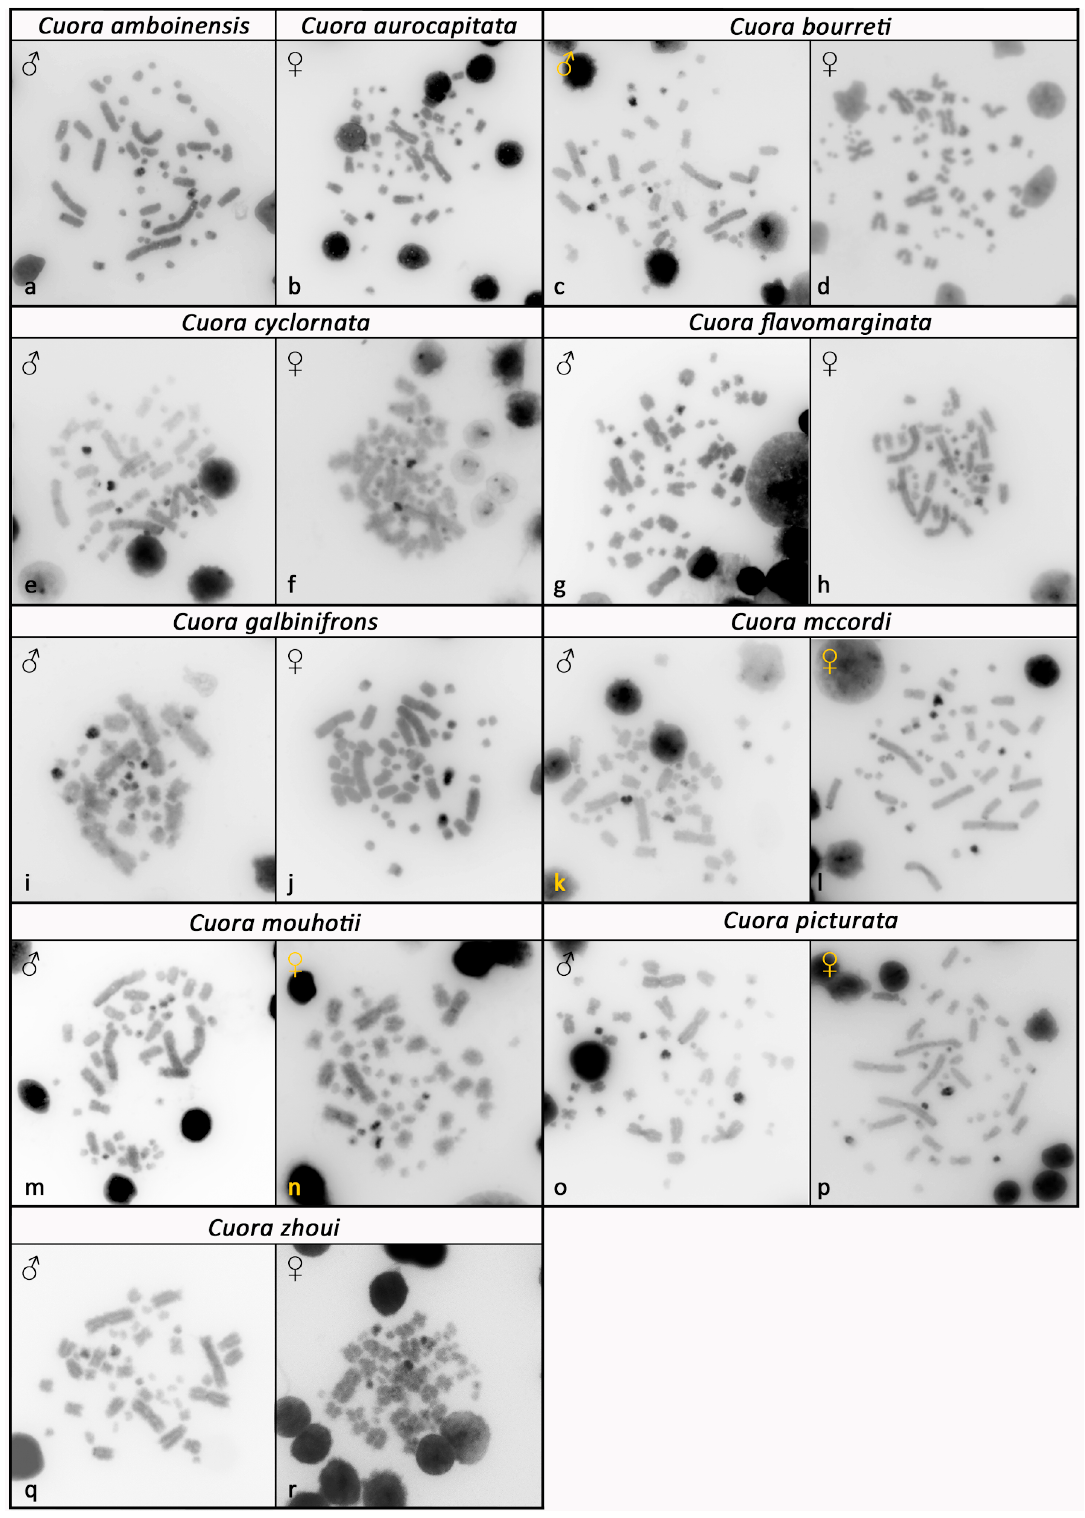
Figure 2. C-banded metaphases of Cuora amboinensis ( a ), Cuora aurocapitata ( b ), Cuora bourreti ( c , d ), Cuora cyclornata ( e , f ), Cuora flavomarginata ( g , h ), Cuora galbinifrons ( i , j ), Cuora mccordi ( k , l ), Cuora mouhotii ( m , n ), Cuora picturata ( o , p ), and Cuora zhoui ( q , r ). Prominent heterochromatic blocks were detected in both chromosomes of the 14 th pair in all species as well as in other smaller microchromosomes.